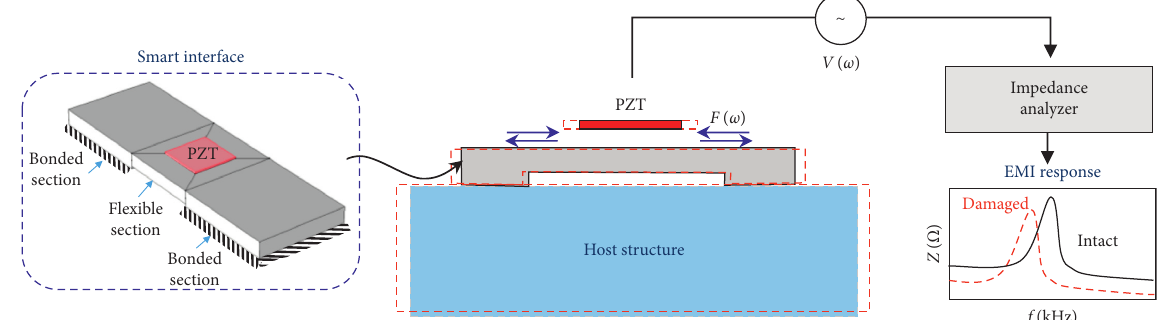
Figure 1: Overview of the EMI-based damage monitoring method via the smart